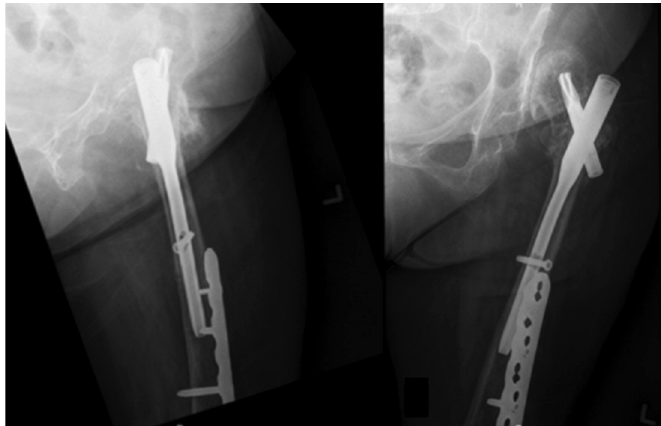
Post-operative radiographs showed the left hip fracture has well healed. No evidence of implant Fig. 3: